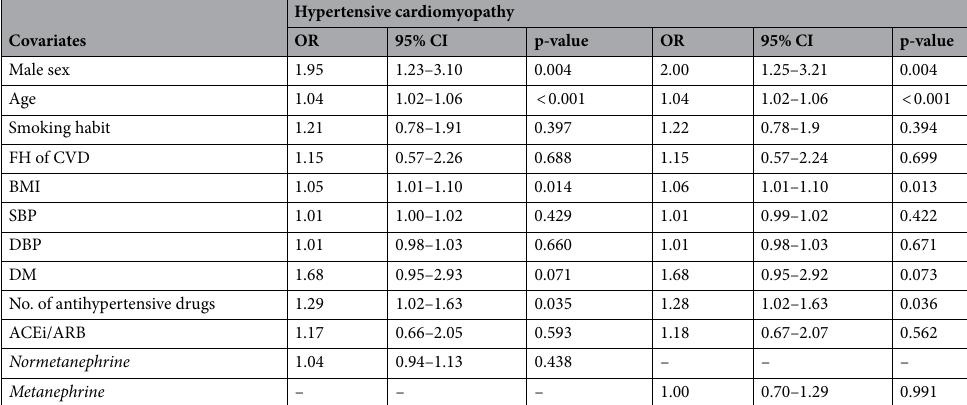
Table 6. Logistic regression analysis on the association of metanephrines and covariates with presence of hypertensive cardiomyopathy (ORs of normetanephrine and metanephrine are calculated for a unit of increase of 100 μg/day). ACEi/ARB, angiotensin converting enzyme inhibitors or angiotensin II receptor blockers; BMI, body mass index; CI, confidence interval; CVD, cardiovascular disease; DBP, diastolic blood pressure; DM, diabetes mellitus; FH, family history; OR, odds ratio; SBP, systolic blood pressure.